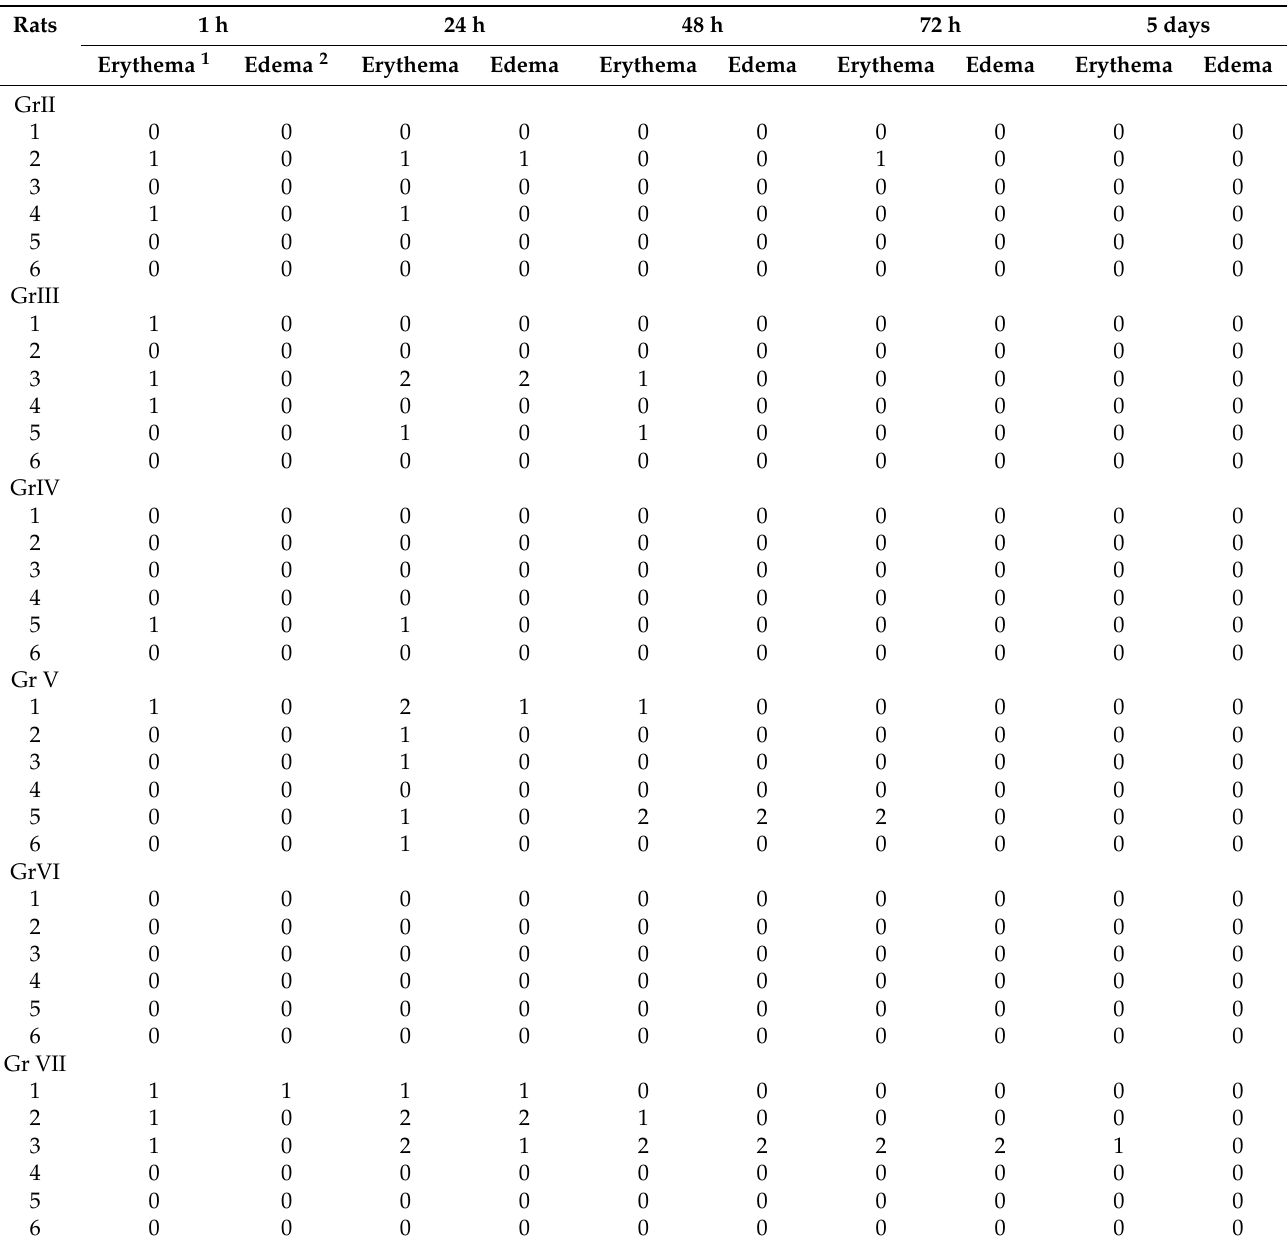
Table 8. Dermal observation in rats with Origanum vulgare , Thymus vulgaris , and Rosmarinus officinalis essential oils at 0.5% and 5%